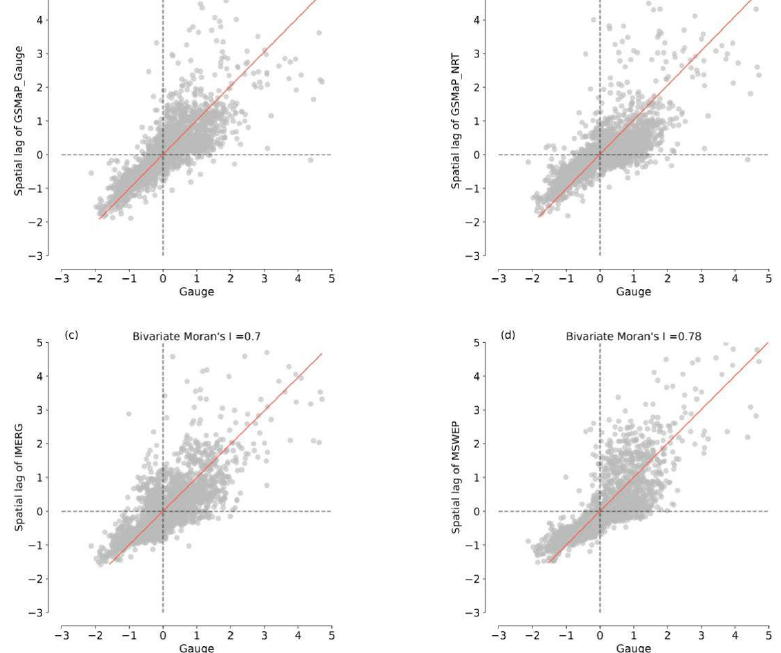
Figure 7. The global BMI scatter plot of CWD between the gauge observations and the four SPPs: ( a ) GSMaP_Gauge, ( b ) GSMaP_NRT, ( c ) IMERG, and ( d ) MSWEP.